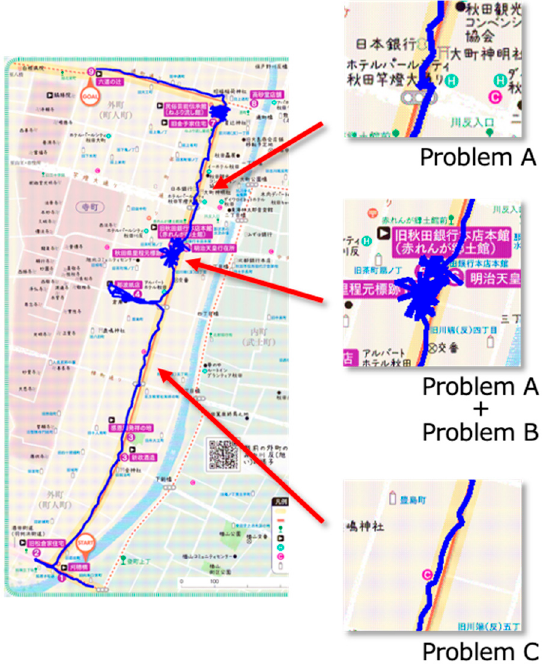
Figure 2. Example display of trajectory log data in the map-based reviewing mode of our application (without any data processing), which illustrates three kinds of problems (A, B, and C). The blue line is a GPS trajectory.